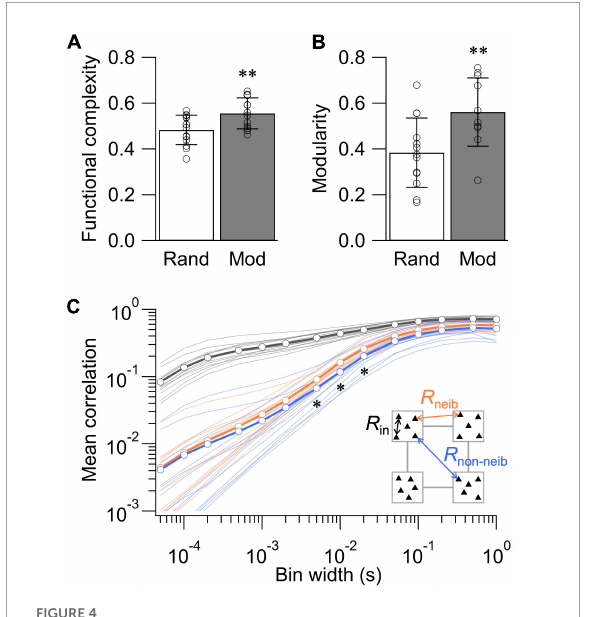
FIGURE4 Structure-function relationships in cultured neuronal networks. (A) Functional complexity for the random and modular networks. (B) Modularity of binarized correlation matrix for the random and modular networks. Data shown as mean ± SD, with plots for individual data points. (C) Dependence of mean correlation coefficient on the bin width of the spike train. R in , correlation between electrodes in the same module; R neib , correlation between electrodes in neighboring modules; R non − neib , correlation between electrodes in non-neighboring (diagonal) modules. ∗ p < 0.05, ∗∗ p < 0.01 (two-tailed t -test).